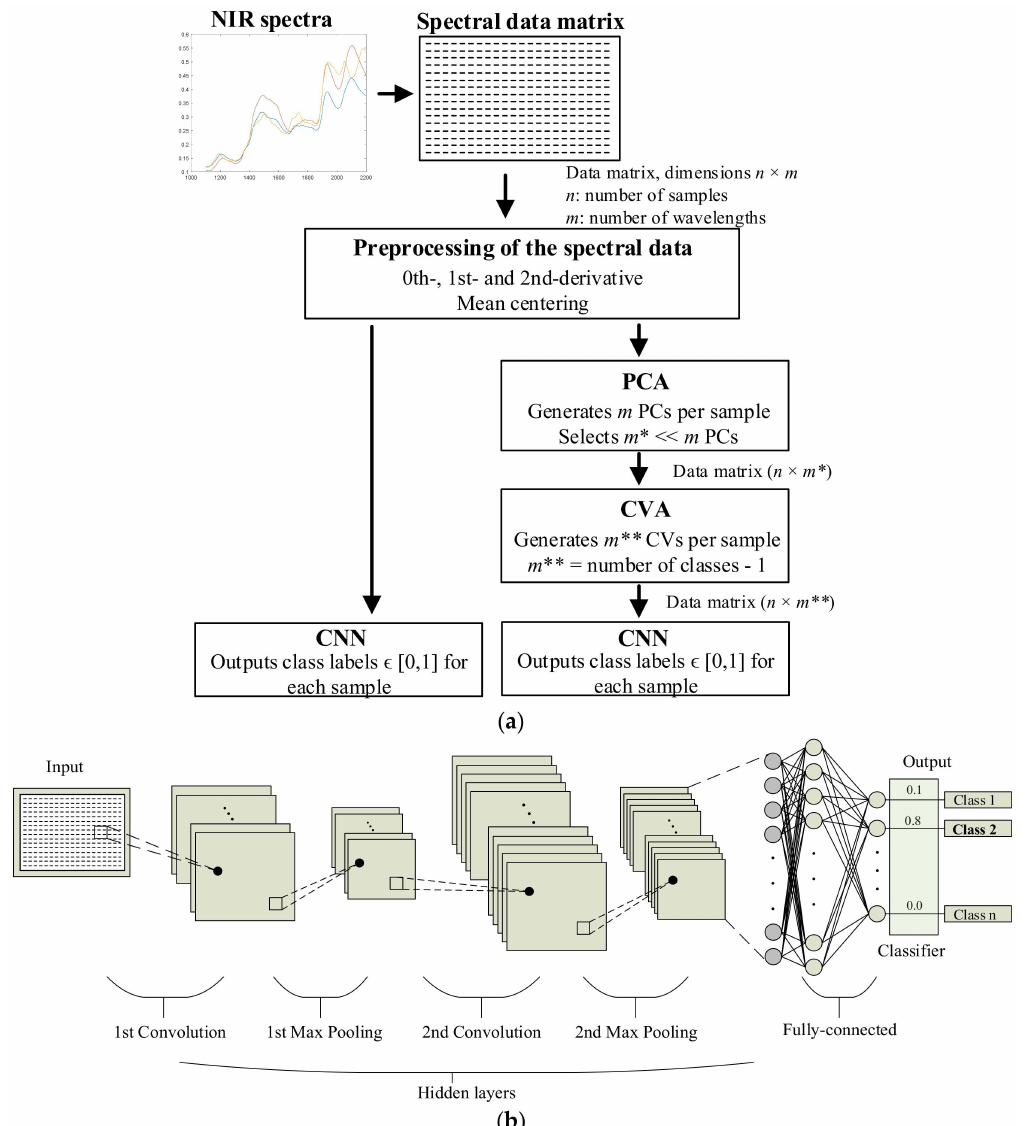
Figure 1. ( a ) Classification approach based on two different paths to classify an unknown fiber sample into one of the preset textile fiber classes from the NIR spectrum. ( b ) Structure of the classification dealt with by the